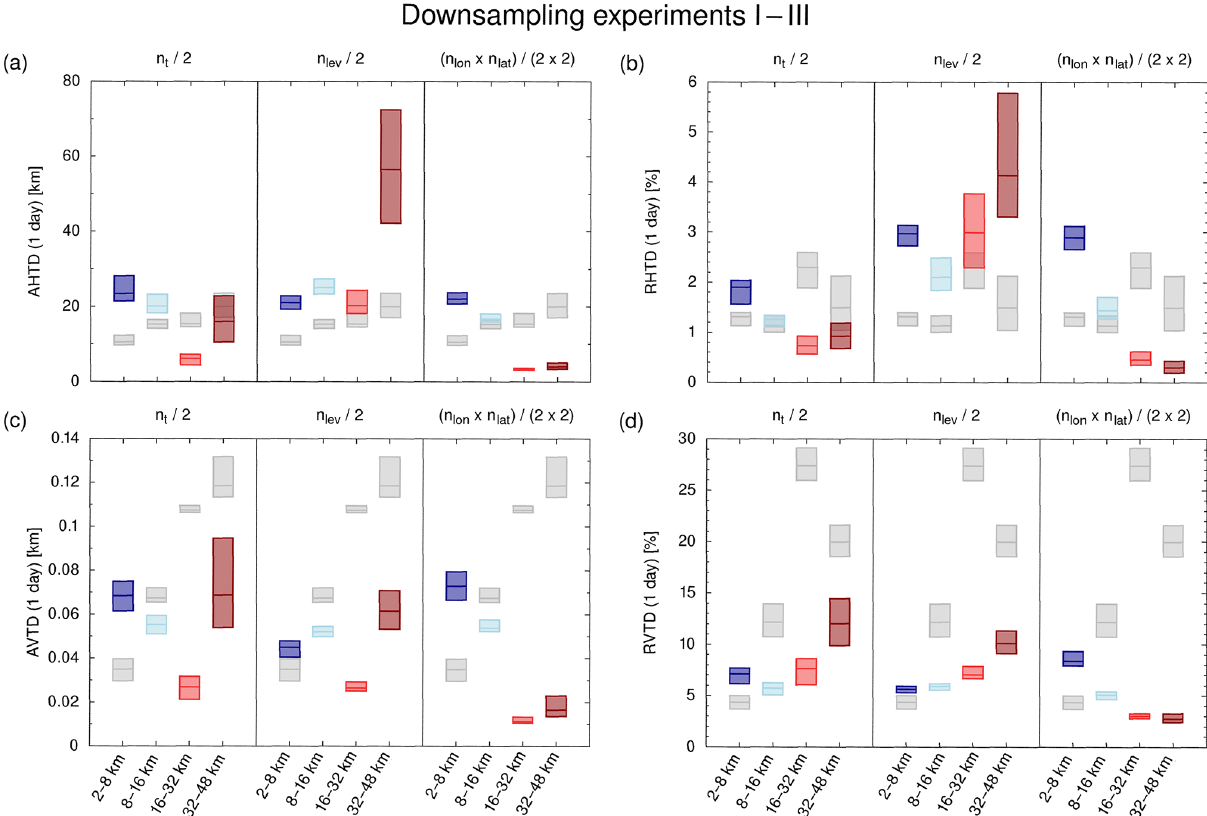
Figure 14. Global transport deviations after 1 day at different height levels caused by downsampling of ERA5 (blue and red bars) and due to parameterized diffusion and subgrid-scale wind fluctuations (light gray bars). The labeling of the plots refers to downsampling of the number of synoptic time steps n t (downsampling experiment I), vertical levels n lev (downsampling experiment II), and horizontal grid points n lon × n lat (downsampling experiment III) of the ERA5 data, respectively.